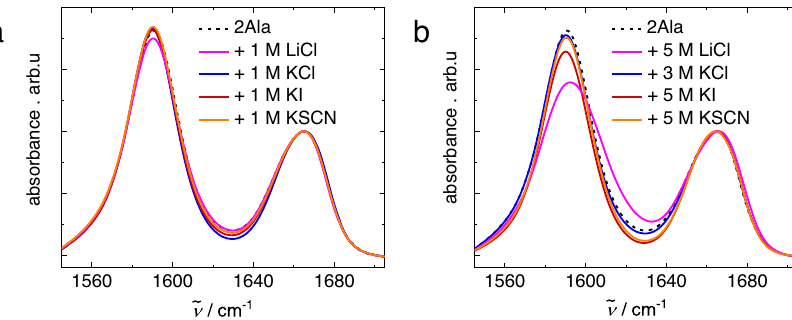
Fig. 6 Salts hardly affect the IR bands of the amide I and anti-symmetric carboxylate stretching mode. Infrared absorption spectra in the absence of salt: 250 mM 2Ala in D 2 O (dashed black line) and in the presence of ( a ) 1 M and ( b ) 5 M (3 M for KCl) salt. Spectra were corrected for a linear background and normalized to the CO peak at ~1660 cm − 1